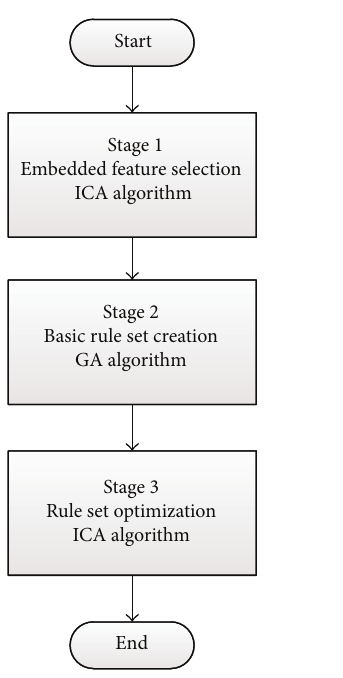
Figure 1: Three main stages in HYEI.